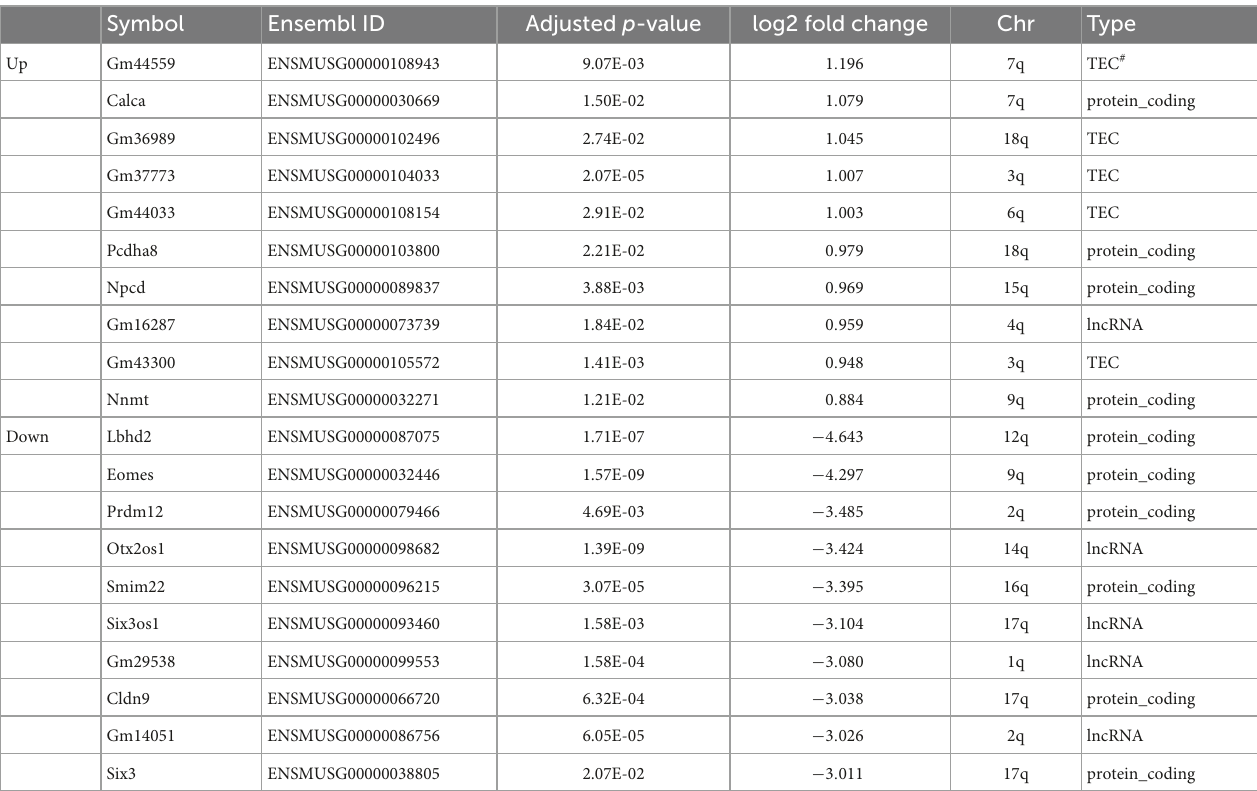
TABLE 2 Top 20 differentially expressed genes based on fold changes (10 up-regulated, 10 down-regulated by